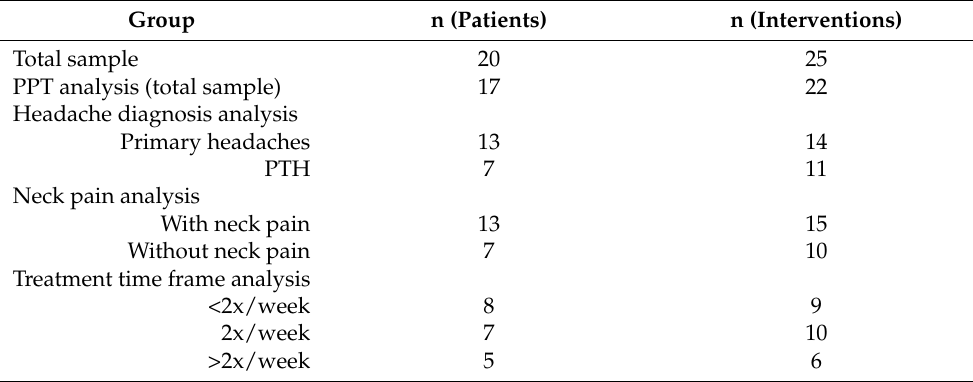
Table 1. Sample sizes for PPT analysis and subgroup